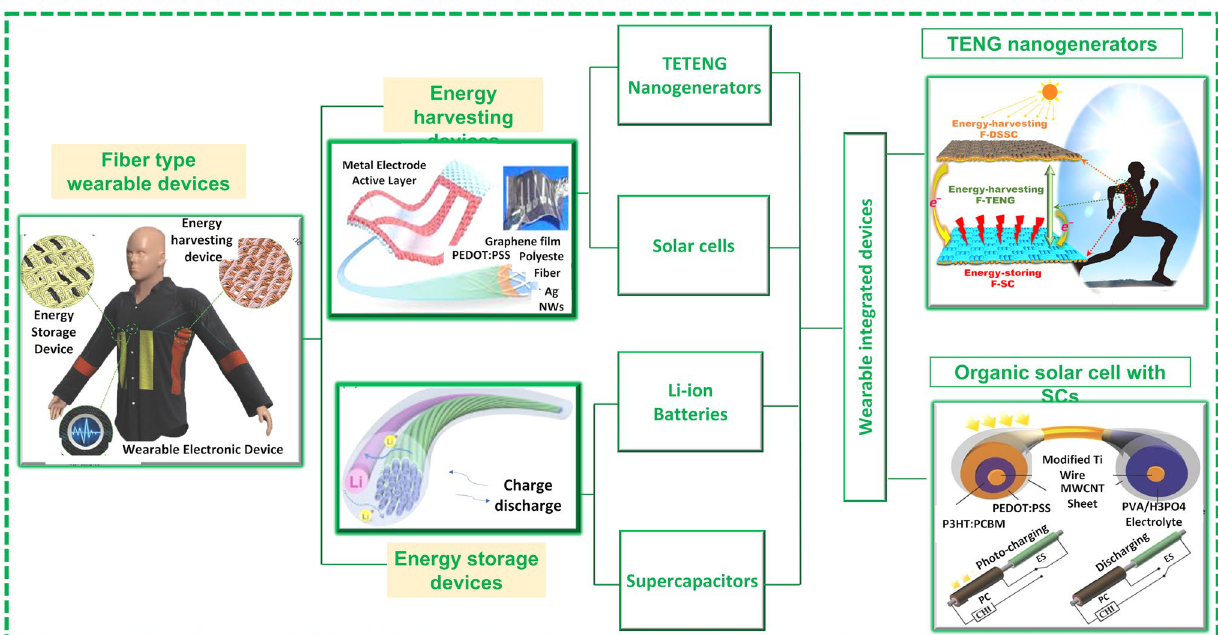
Fig. 2 Graphic representation of the key features of this review article: Reprinted with permission from Refs. [13,